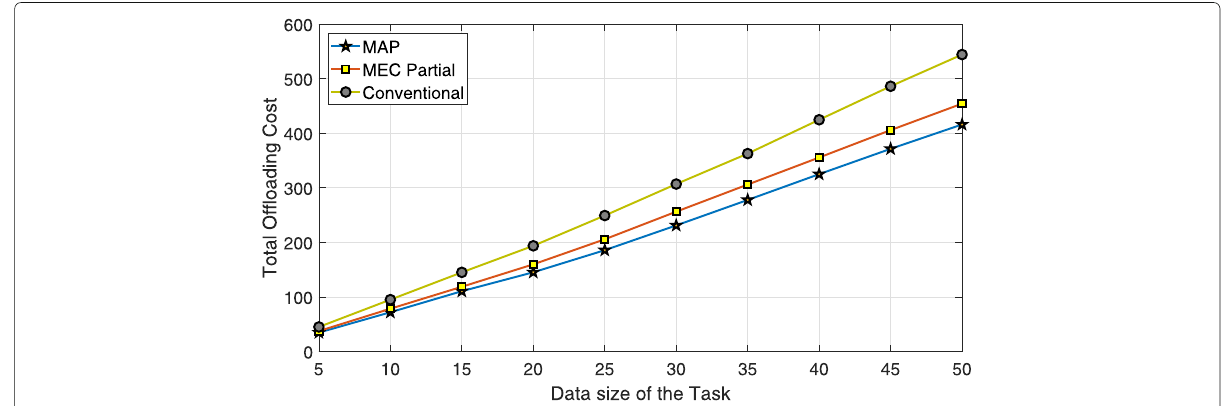
Fig. 6 The total offloading cost to data size D n , when RHVs=10 & RRVs=10